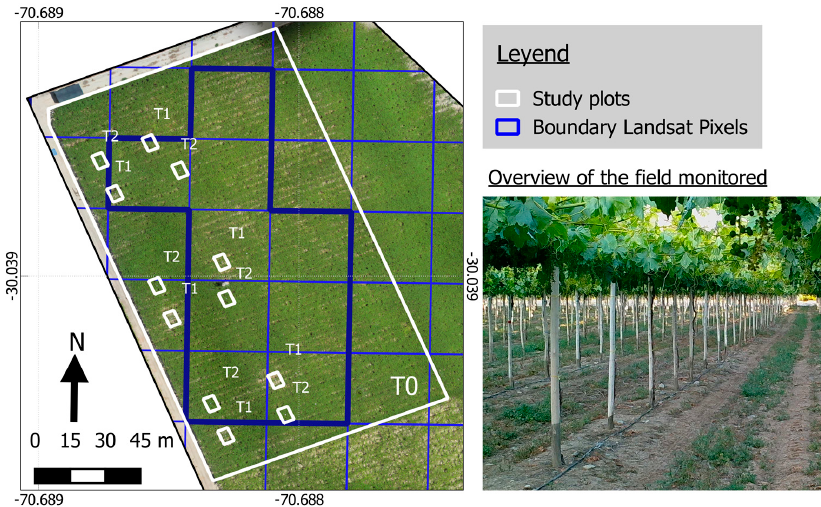
Figure 1. Experimental plot with irrigation treatments distribution, boundary of Landsat pixels, and overview of the plants in the field.